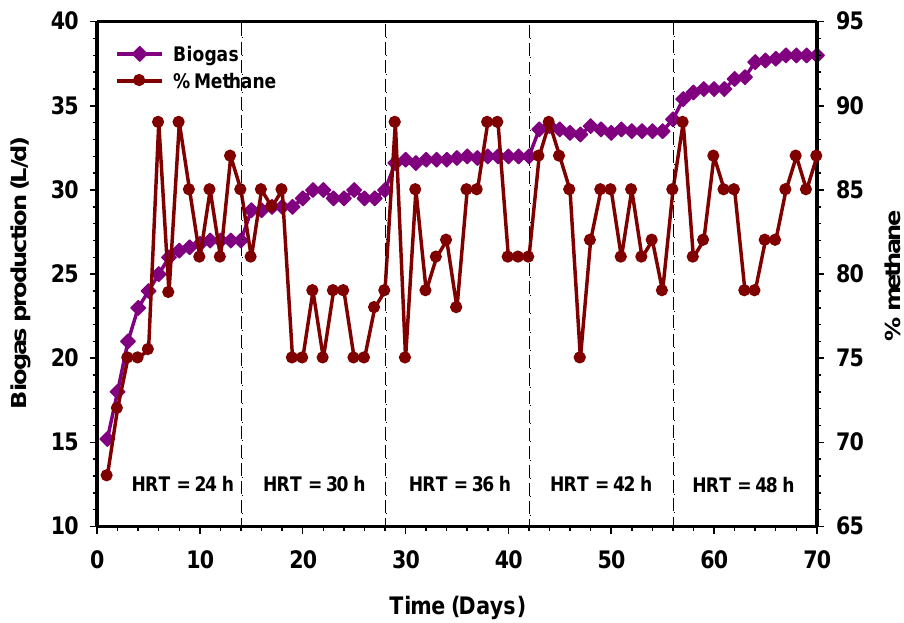
Figure 3. Variation of biogas production relative to increasing contact time.